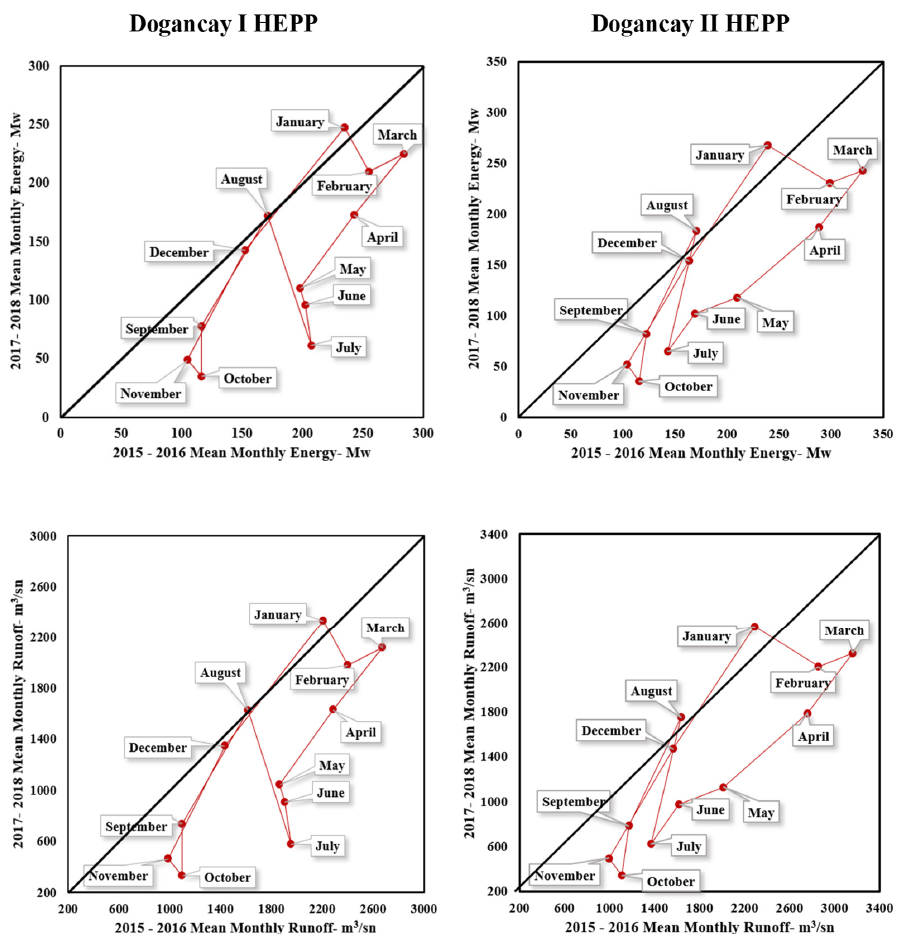
Figure 5. IPTA Method Graphs of Arithmetic Mean Analysis Results of Dogancay I and II HEPPs.